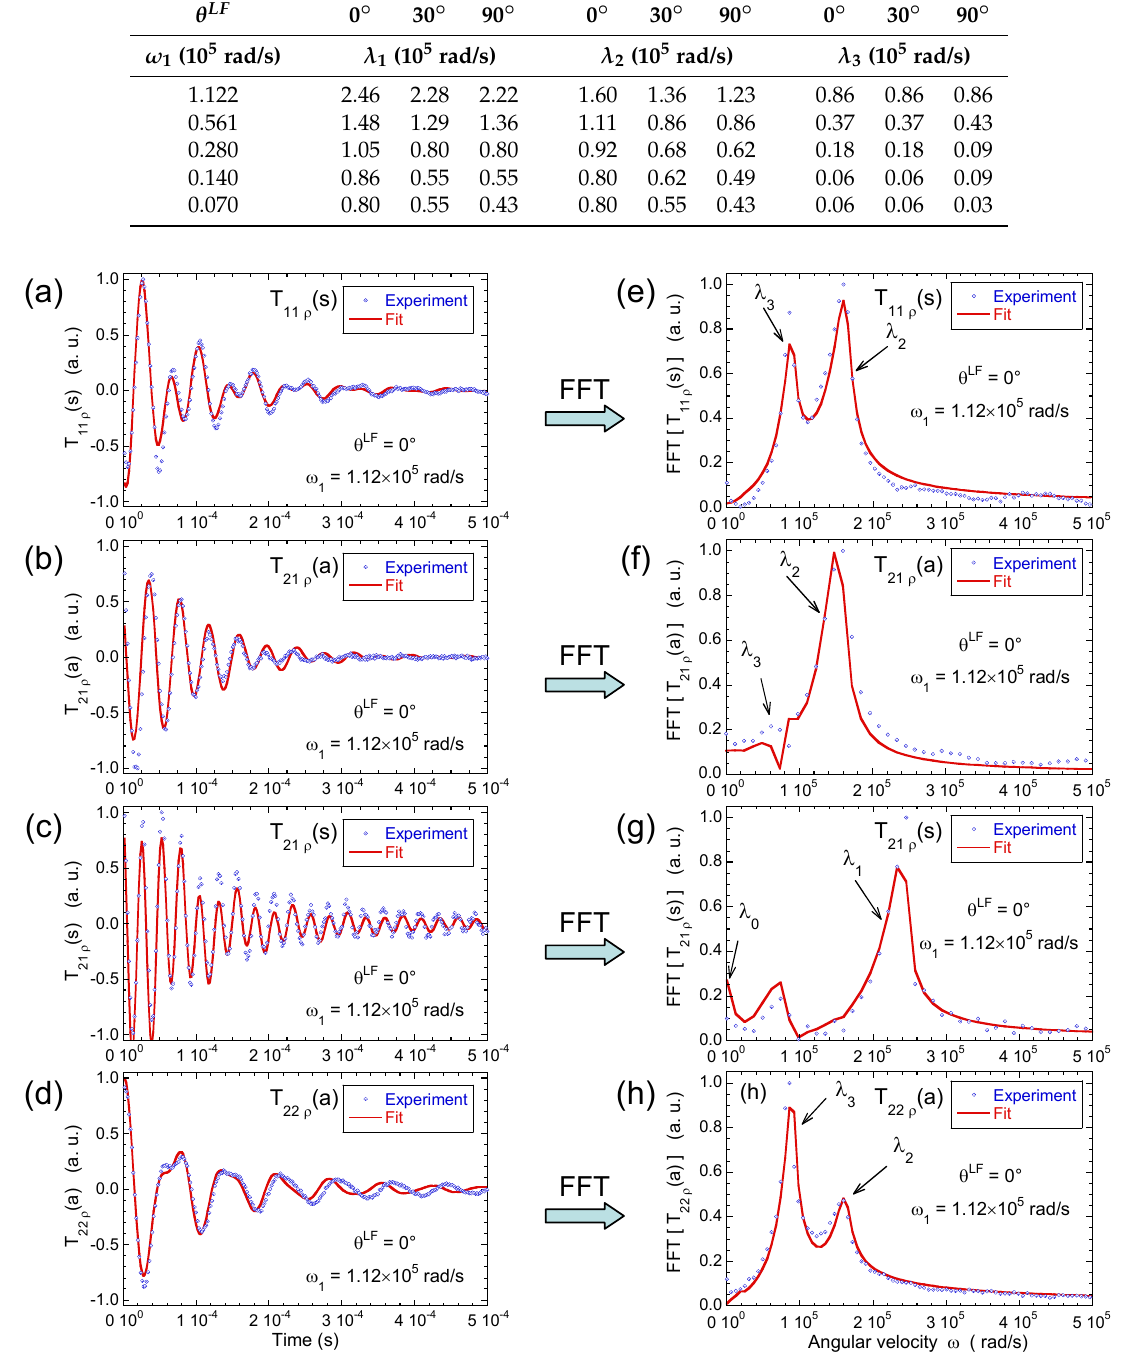
Figure 7. Time evolution of ( a ) T 11 ( s ) ; ( b ) T 21 ( a ) ; ( c ) T 21 ( s ) and ( d ) T 22 ( a ) coherences measured under spin-lock conditions, denoted T 11 ρ ( s ) , T 21 ρ ( a ) , T 21 ρ ( s ) and T 22 ρ ( a ) , respectively, and their Fourier transforms for ( e ) T 11 ( s ) ; ( f ) T 21 ( a ) ; ( g ) T 21 ( s ) and ( h ) T 22 ( a ) coherences ( 2 H NMR). Reprinted with permission from [53]. Copyright (2014) American Chemical